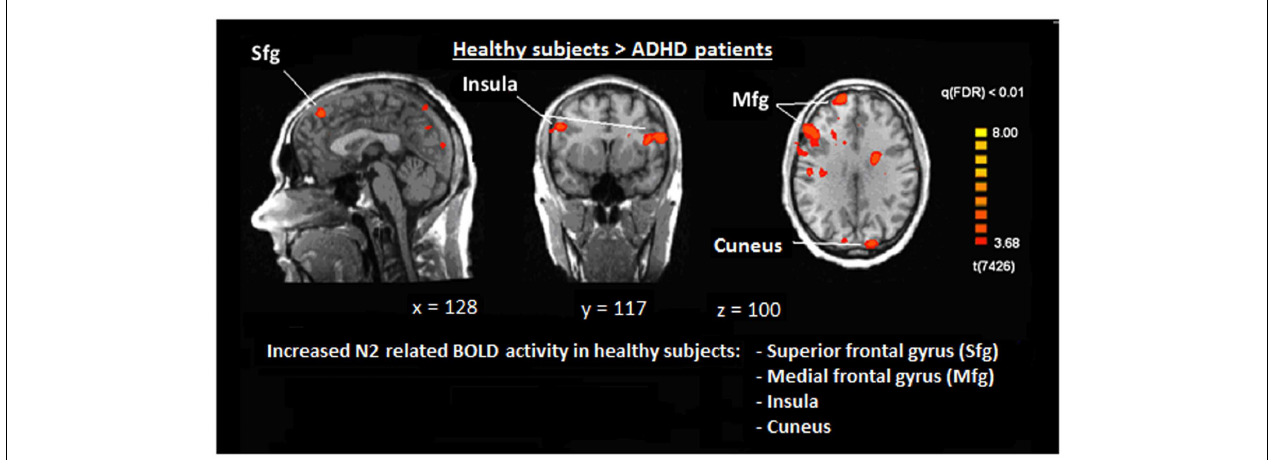
FIGURE 6 | Comparison of N2-associated BOLD activity of healthy subjects andADHD patients during voluntary selection condition [fixed effects analysis; q (FDR) < 0.01] . Healthy subjects demonstrated increased responses, e.g., in the superior frontal gyrus, medial-frontal gyrus, insula, and cuneus.